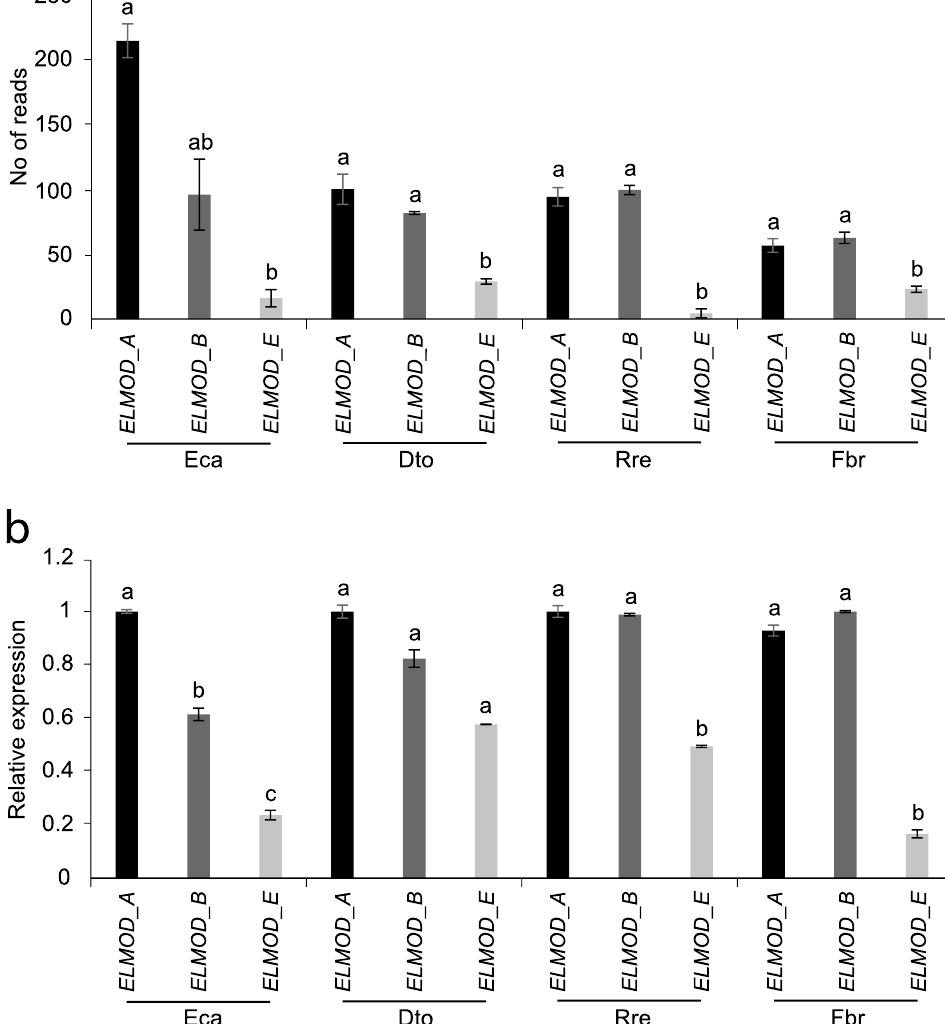
Figure 7. Comparison of ELMOD -like gene expression in anthers in the tetrad stage of pollen development. ( a ) ELMOD -like gene expression obtained by transcripts quantification. Values correspond to the number of reads per gene quantified using StringTie coverage values. ( b ) ELMOD -like gene expression obtained by RT-qPCR analysis. Values on the y-axis correspond to the relative expression intensities, obtained using the 2 ∆∆ Ct method, of each gene in relation to the most highly expressed gene (arbitrary value = 1) within each species. Eca, Eschscholzia californica ; Dto, Dactylicapnos torulosa ; Fbr, Fumaria bracteosa ; Rre, Roemeria refracta. Different letters above the bars within each species indicate statistically significant differences in gene expression according to Tukey’s test ( p <